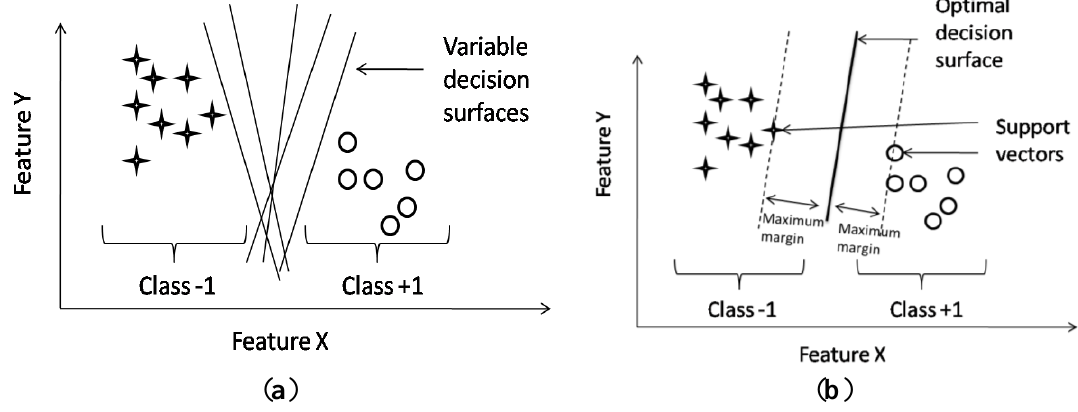
Figure 3. Example of two-class (+1 & −1) problem. The circles and stars represent samples of class +1 and −1, respectively. ( a ) multiple decision surfaces and ( b ) optimal decision